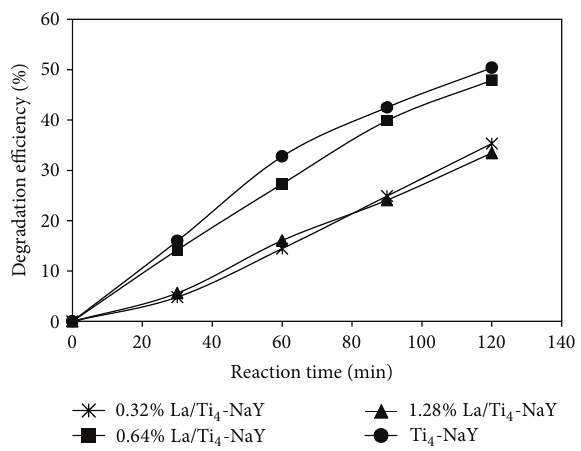
Figure 9: Degradation of Amaranth for Ti 4 -NaY catalysts with dif- ferent loadings of lanthanum (10mg/L initial dye solution, catalyst loading 1.5g/L, and original